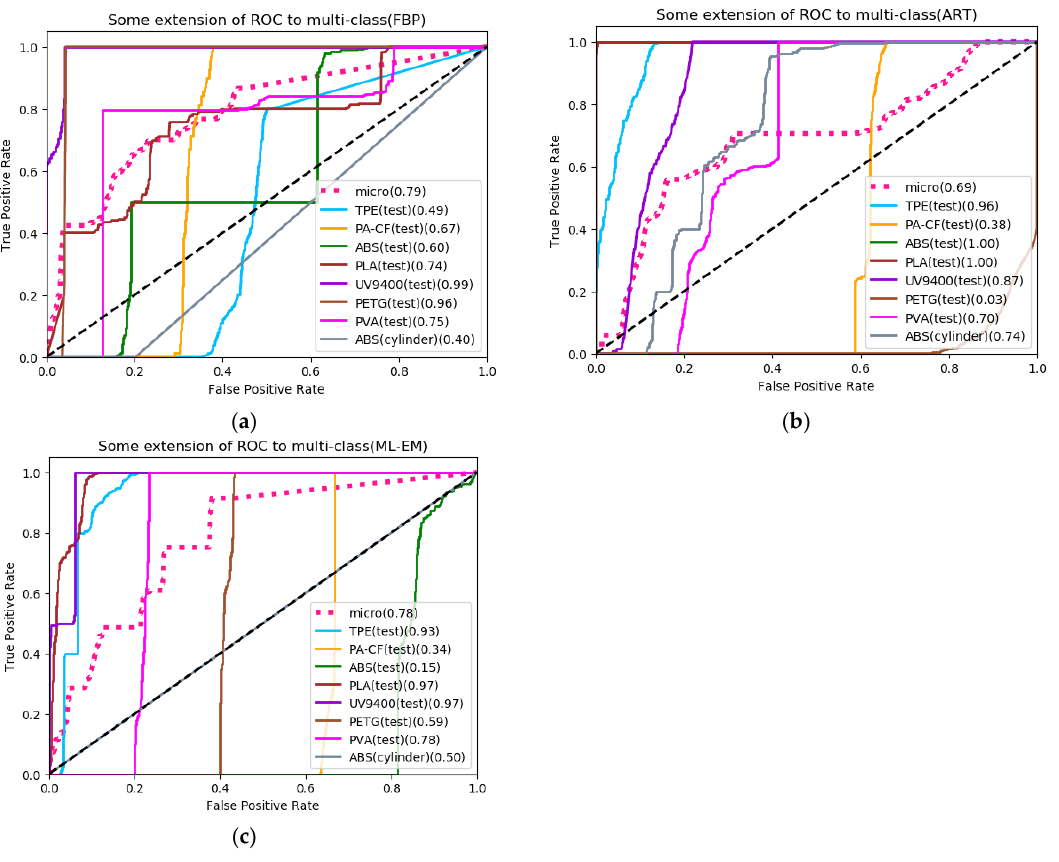
Figure 14. ( a ) ROC curves for prediction result of XAS reconstructed by FBP and ART ( b ) as well as ML-EM ( c )